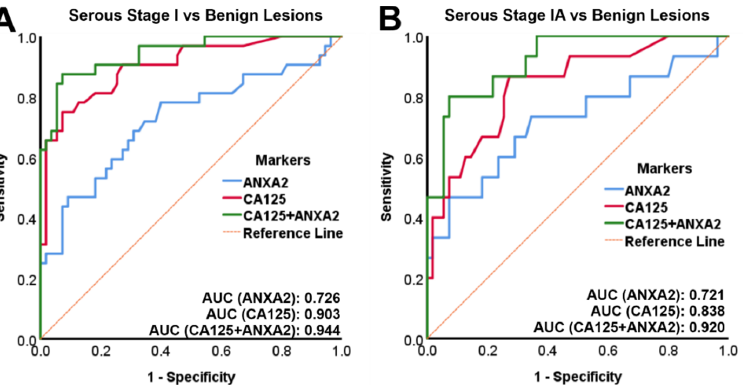
Figure 3. ROC curves for stage I OC versus benign ovarian tumors. ( A ) Plasma annexin A2 or CA125 alone and combined plasma annexin A2 + CA125 for stage I OC ( n = 32) versus benign ovarian tumors ( n = 55). ( B ) Plasma annexin A2 or CA125 alone and combined plasma annexin A2 + CA125 for stage IA OC ( n = 15) versus benign ovarian tumors ( n = 55). AUC: area under the curve; ROC: receiver operating characteristics. Table 3. Specificity (%) of ANXA2, CA125 and ANXA2 + CA125 at 100%, 94% and 75% sensitivity. AUC from the ROC curve for stage I-IV OC versus benign ovarian tumors using logistic regression model. Marker